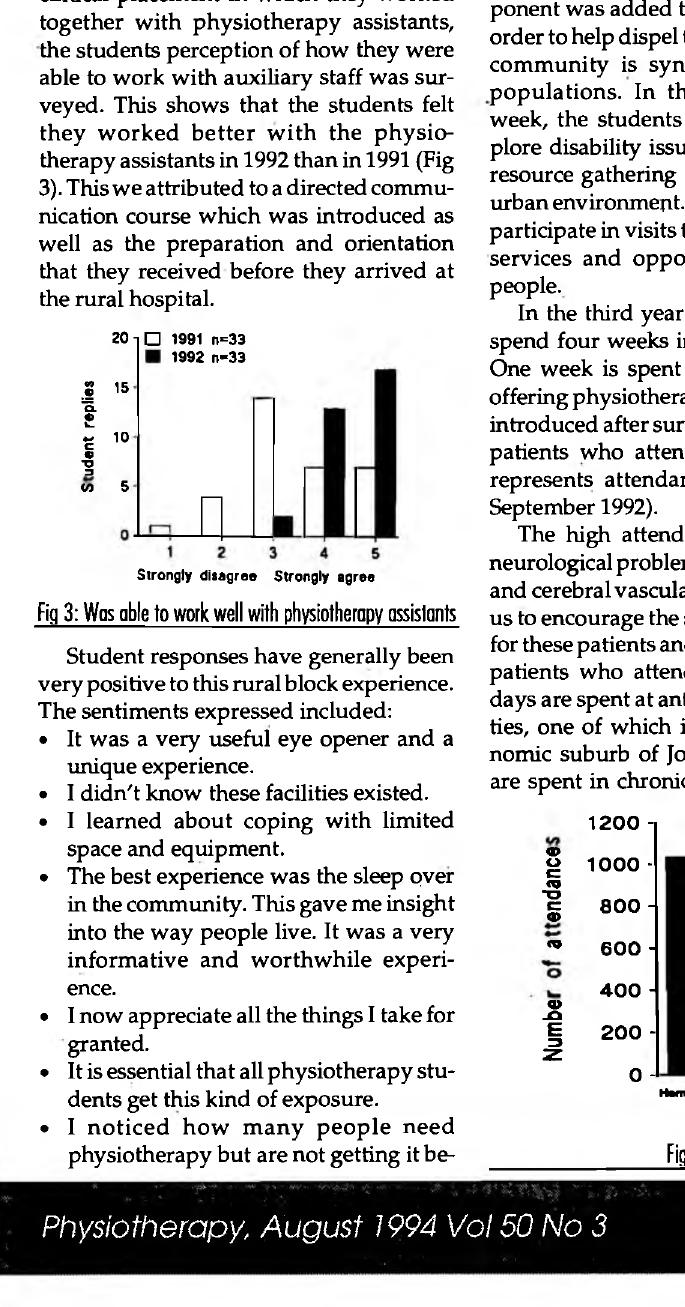
Fig 5: Attendances at Soweto Clinics continued